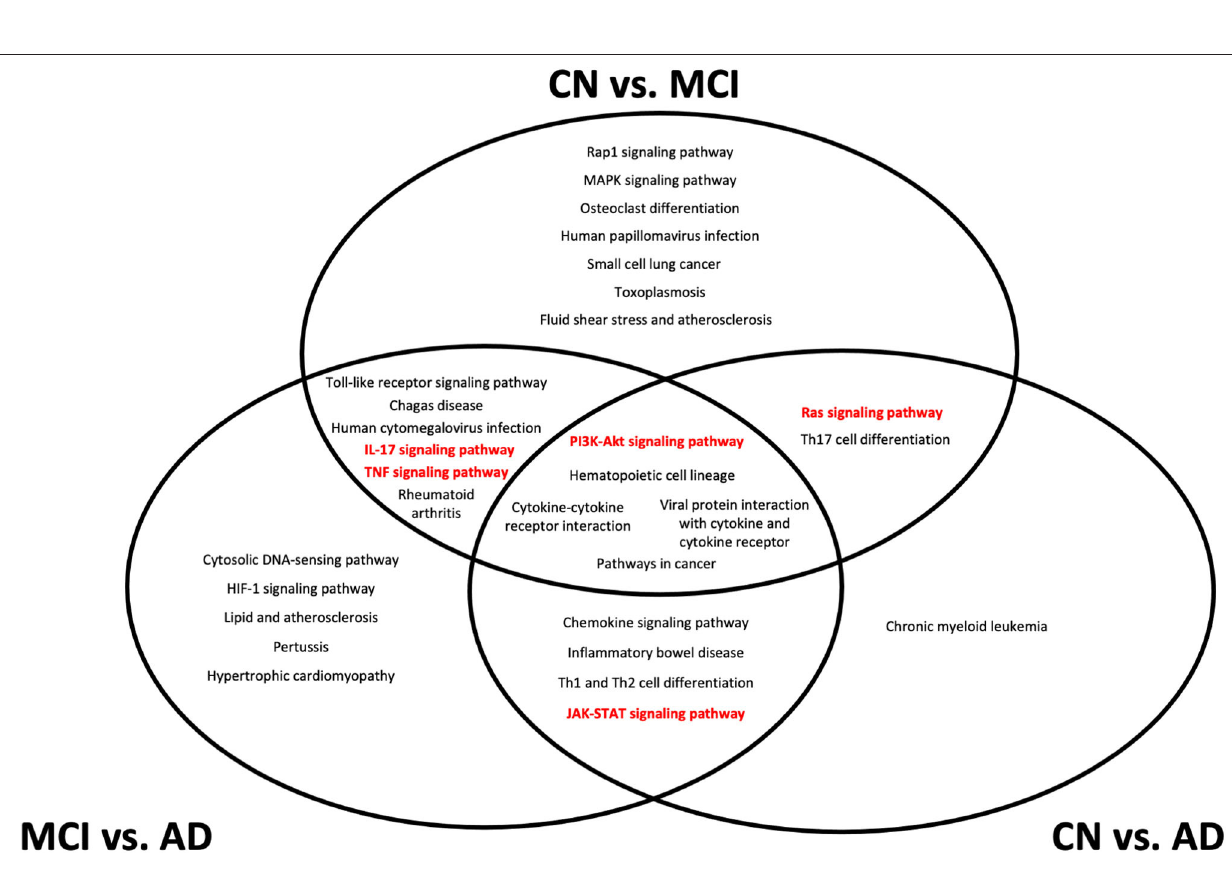
Frontiers in Digital Health | www.frontiersin.org 7 July 2022 | Volume 4 | Article